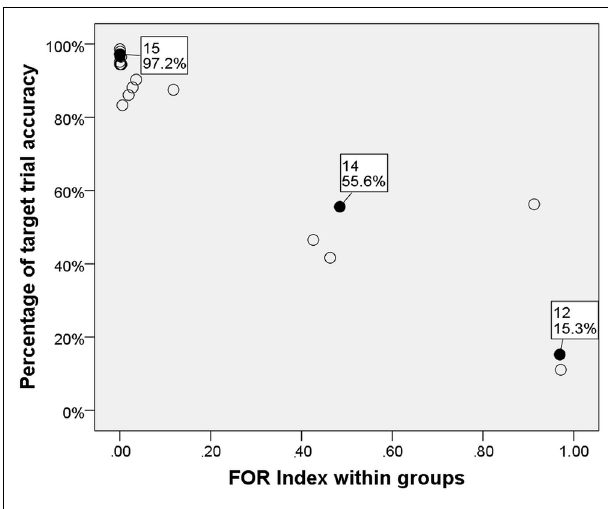
FIGURE 7 | Scatter plot of target accuracy and difference scores within